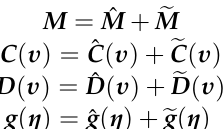
Figure 2. The active TAG hydrothermal field [31].